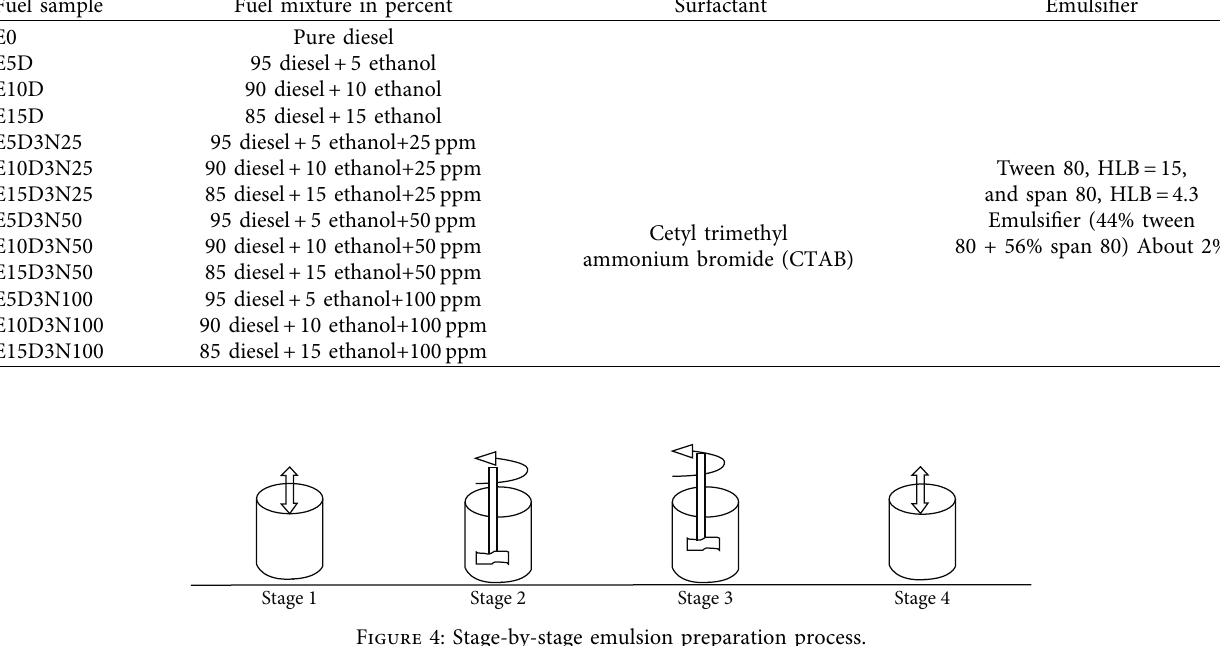
Table 6: Test fuel preparation.